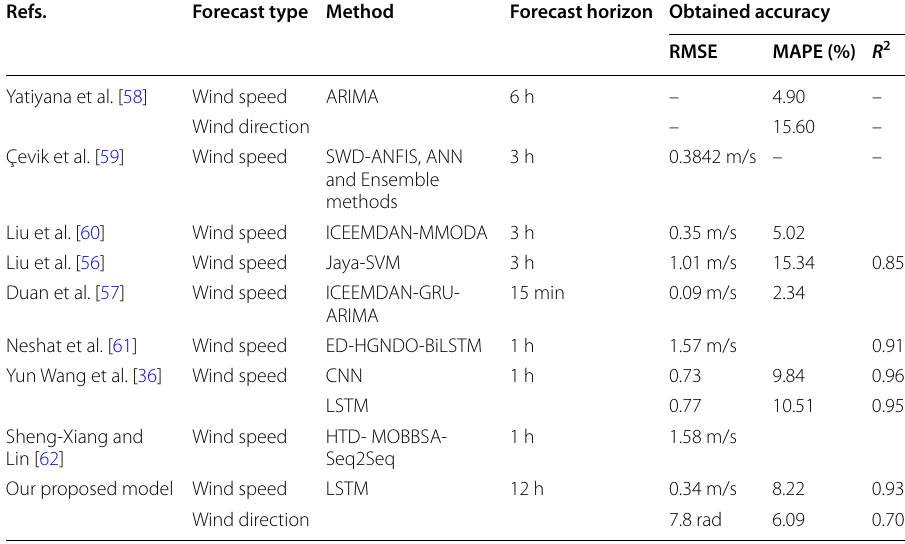
Table 6 Performance comparison